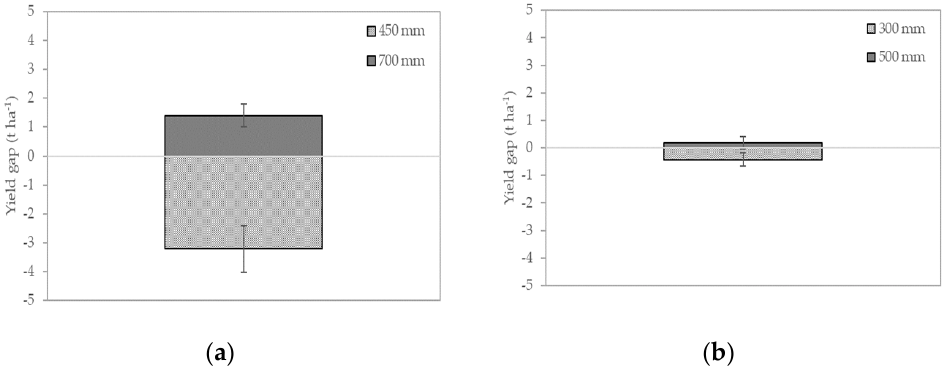
Figure 8. Average potential dry root yield gap of the different irrigation water allocation scenarios with respect to the normal irrigation water allocation (reference scenario) for the 30 simulated seasons in the two main productive areas: ( a ) North (Valladolid), and ( b ) South (Sevilla). Vertical bars represent the standard deviation.